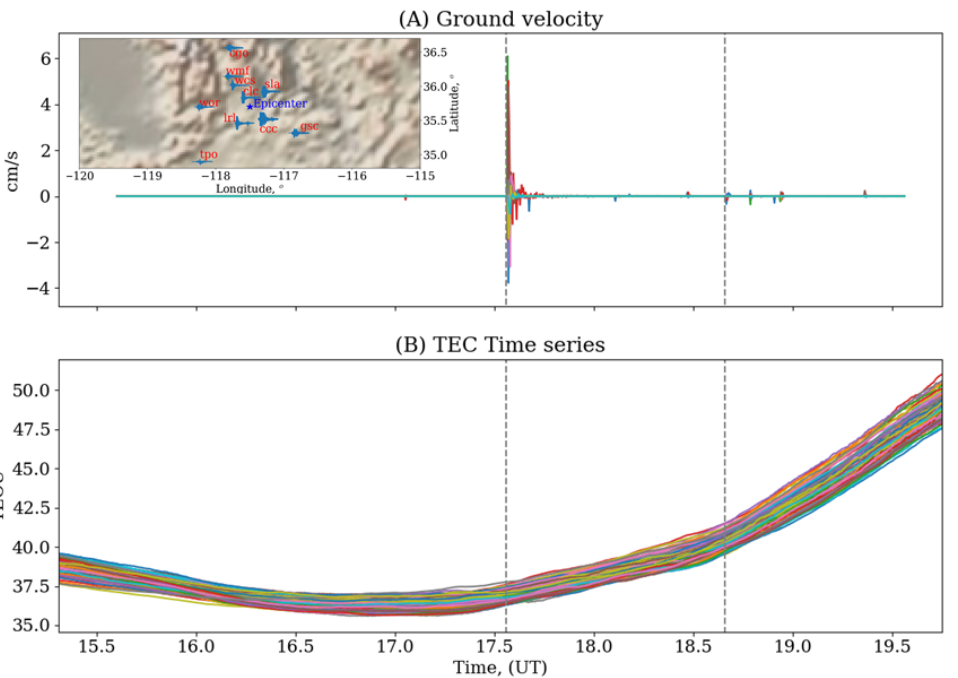
Figure 2. ( A ) Vertical ground velocity at 10 seismic stations located within 1 ◦ of the epicentral distance; the inset map shows an amplification around the velocity mainshock. ( B ) TEC values as registered from various stations (total number = 110) located within a ± 1.25 ◦ epicentral distance at the mainshock onset time. For seismic station with latitude ( lat s ) and longitude ( lon s ), epicen- (cid:113) ( lat s − lat ep ) 2 + ( lon s − lon ep ) 2 . For GPS trajectories, it is defined as tral distance is defined as (cid:113) ( lat − lat ep ) 2 + ( lon − lon ep ) 2 , where ( lat 0 0 0 , lon 0 ) are the latitude and longitude of the IPP tra- jectory at the onset time of the mainshock. Here, ( lat ep , lon ep ) is the epicenter coordinate. Vertical dashed lines indicate the onset time of the mainshock of Mw 6.4 and the largest aftershock of Mw